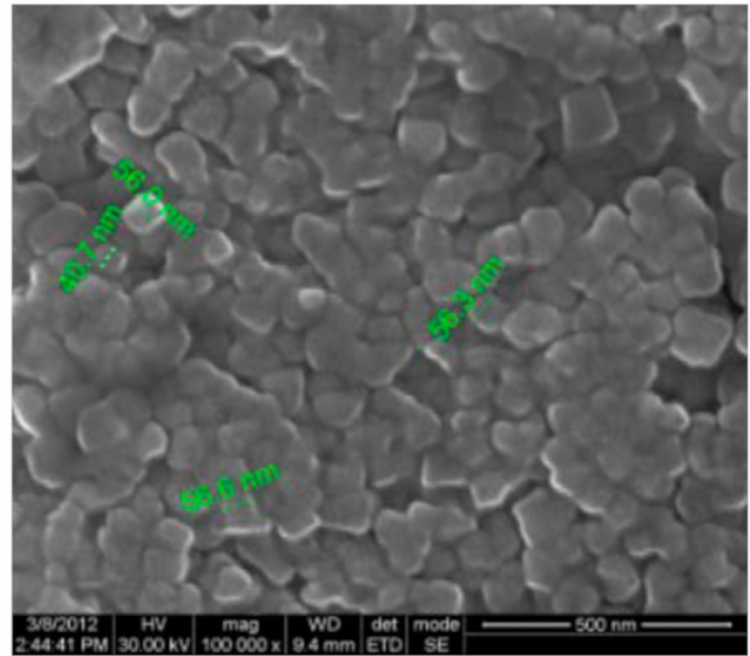
Figure 3. SEM images of Ag-NP obtained using aqueous extract of marine seaweed Ulva lactucain